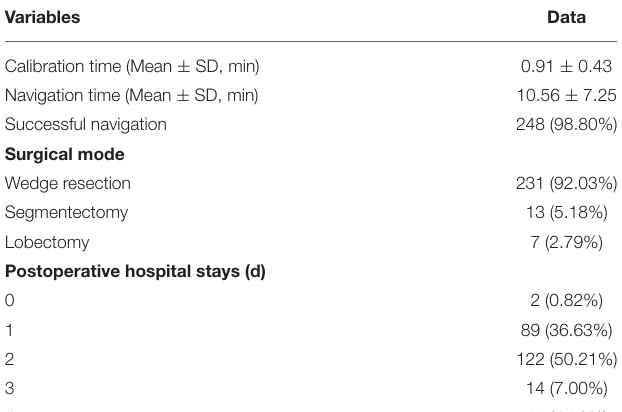
TABLE 3 | Perioperative data.